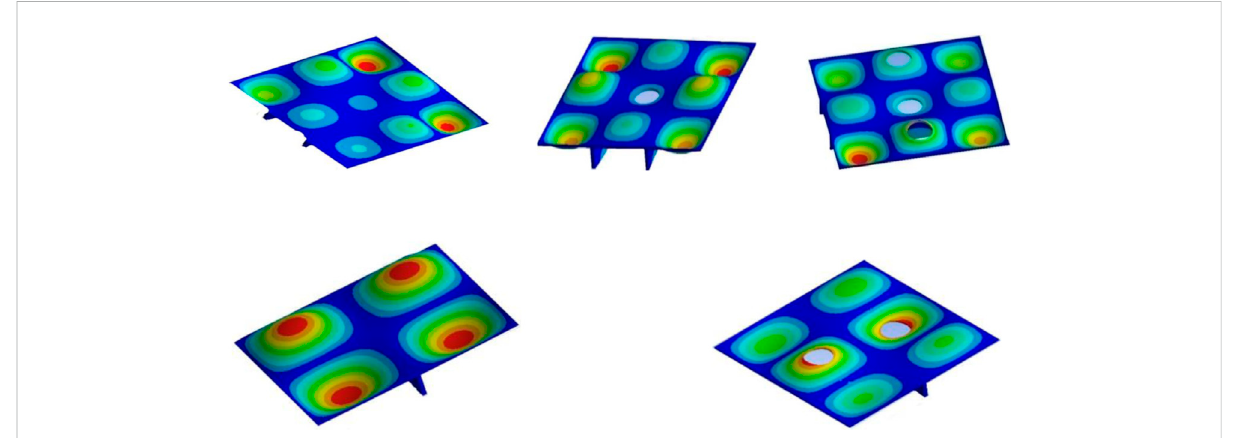
FIGURE 10 First modal vibration mode shape for perforated stiffened plates.